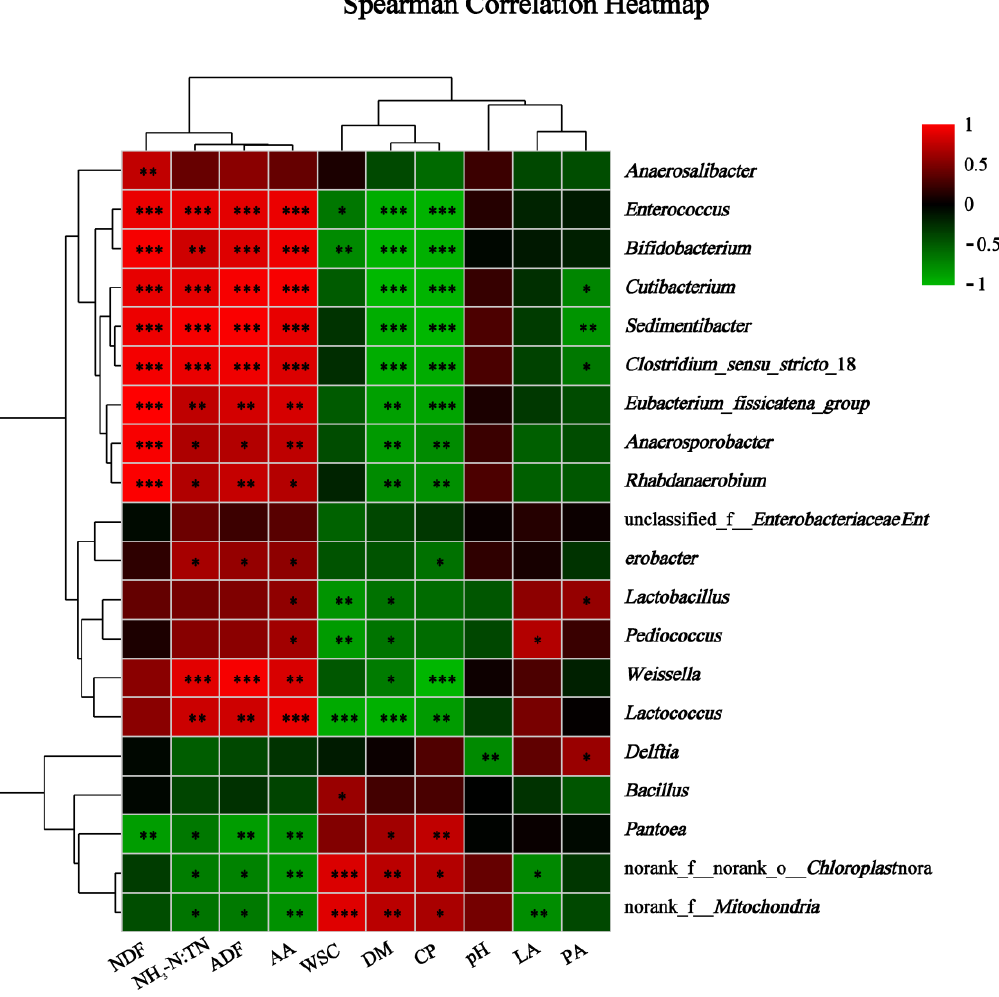
Figure 6. Heatmap displaying the correlations between the relative abundances of bacteria at the genus level and the fermentation variables of alfalfa silage. * p < 0.05, ** p < 0.01, *** p < 0.001. DM, dry matter; NH 3 -N:TN, ammonia nitrogen:total nitrogen ratio; CP, crude protein; WSC, water-soluble carbohydrate; NDF, neutral detergent fiber; ADF, acid detergent fiber; LA, lactic acid; AA, acidic acid; PA, propionic acid.